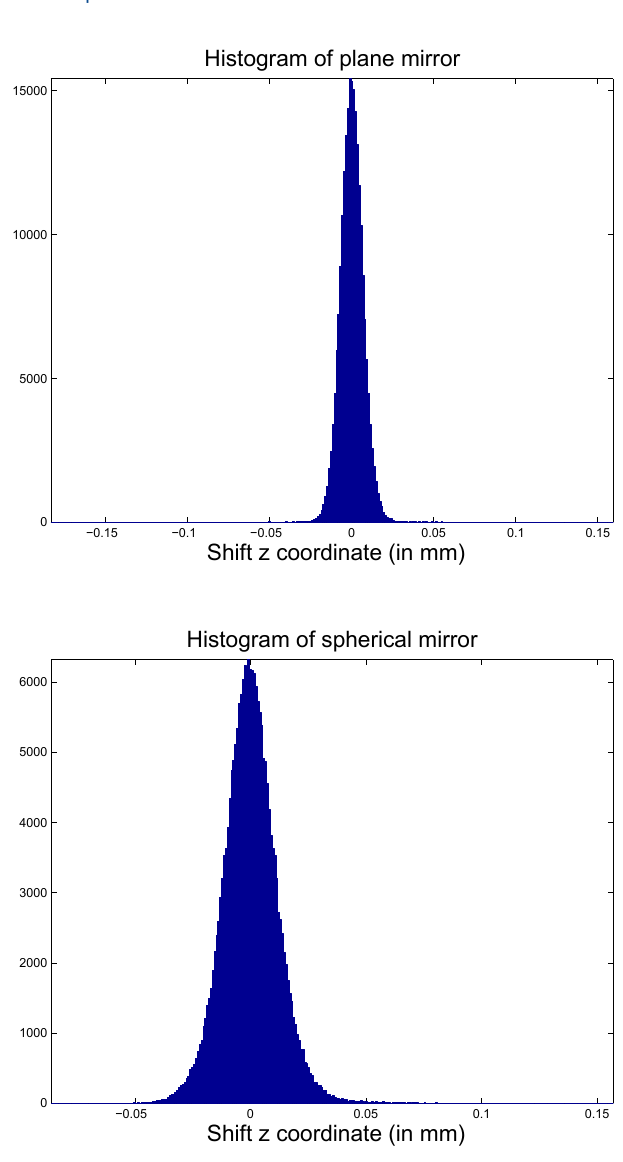
Figure 6. Top panel: residuum of the measured z coordinate and the z coordinate after data fusion in the plane reference mirror case. Bottom panel: residuum of the measured z coordinate and the z co- ordinate after data fusion in the spherical reference mirror